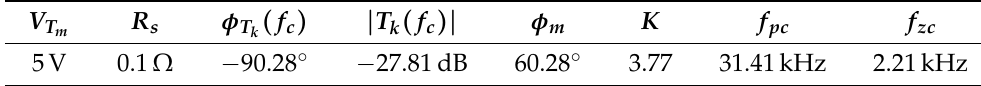
Table 5. Parameters of the ISLC with a GCF equal to 8.3 kHz.